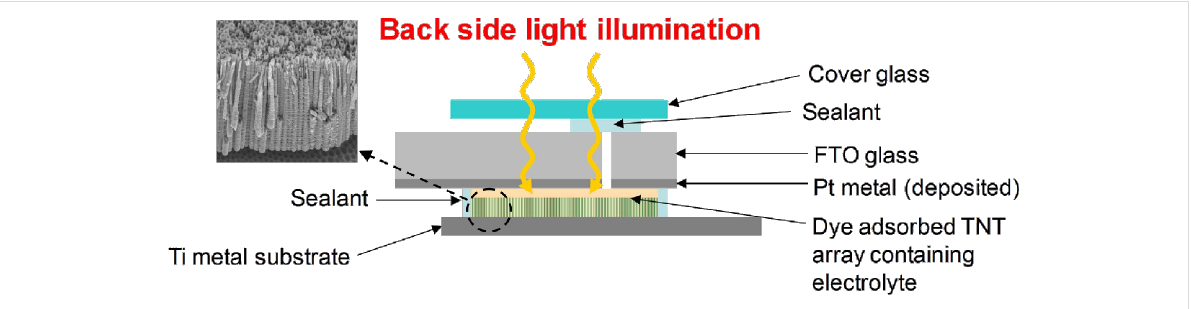
Figure 1: Schematic diagram of TNT-based DSSCs under back side light illumination (Inset SEM image indicates well-ordered TNT arrays prepared by anodization).